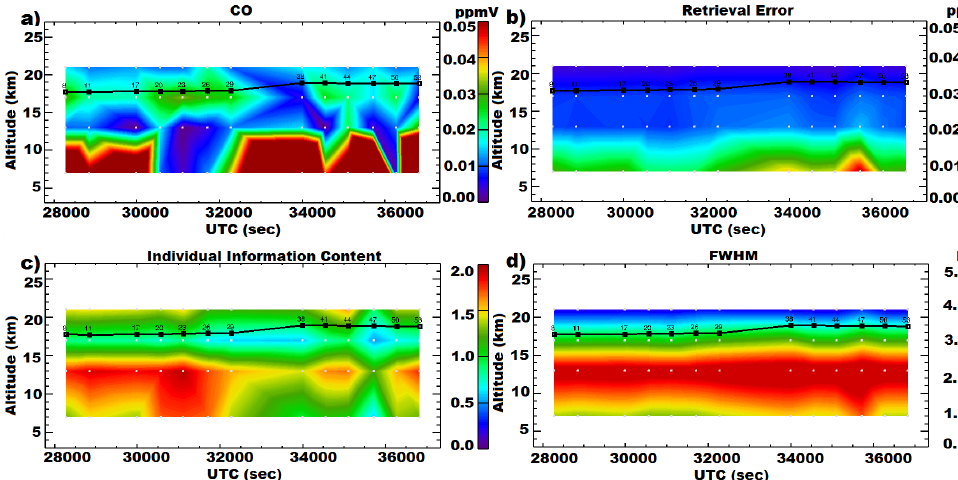
Fig. 15. As in Fig. 5 but for CO retrieved from band D.